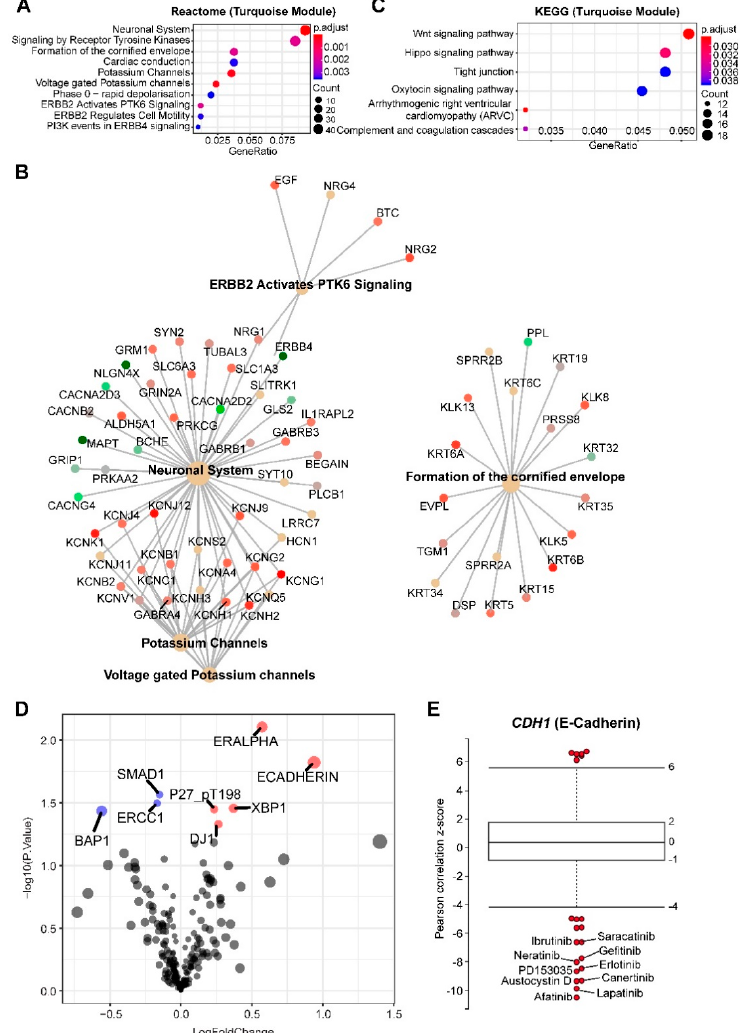
Figure 4. Enrichment analyses of genes significantly correlated with MPM tumors with SETD2 alterations. ( A , C ) Top 10 significantly enriched Reactome ( A , B ) and Kyoto Encyclopedia of Genes and Genomes (KEGG) ( C ) pathways based on genes in the turquoise module. Cnetplot in ( B ) listed genes in the enriched Reactome pathways ( A ). ( D ) Volcano plot showing the significantly (adjusted p -value < 0.05) upregulated (red) and downregulated (blue) proteins in malignant pleural mesothelioma (MPM) tumors with SETD2 alterations (versus wild-type), based on The Cancer Genome Atlas (TCGA) MPM cohort ( N = 61). Data were downloaded and reanalyzed from The Cancer Proteome Atlas (TCPA) database (https: // tcpaportal.org / tcpa / ). ( E ) Box-and-whisker plots show the extent of correlation between cytotoxic e ff ects of each compound and with CDH1 (encoding E-cadherin) mRNA level, across 670 solid cancer cell lines. The y-axis indicates z scored Pearson’s correlation coe ffi cients; line, median; box, 25–75th percentile; whiskers, 2.5th and 97.5th percentile expansion; Here, only significantly ( p < 0.05) correlated inhibitors were shown (in red dots). Labeled dots indicated the most negatively correlated